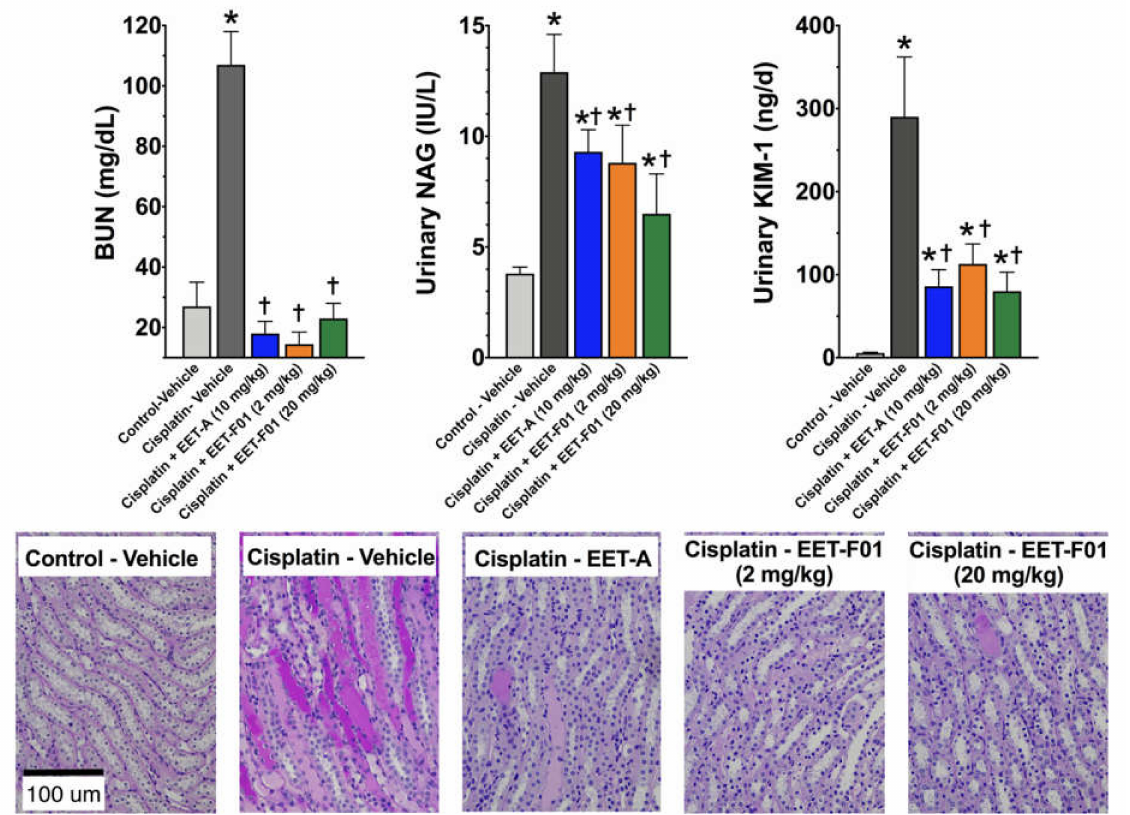
Figure 2. Kidney injury induced by cisplatin is reduced by EET-F01 and EET-A treatments. Left panel: blood urea nitrogen (BUN), Middle panel: urinary N-acetyl- β -(D)-glucosaminidase (NAG), Right panel: kidney injury molecule-1 (KIM-1) in cisplatin administered rats treated with vehicle, EET-F01, or EET-A. Bottom panel: Representative photomicrographs of Periodic acid-Schiff (PAS) Staining depicting vacuolation and desquamation of the renal epithelial cells along with severe intra-tubular proteinaceous cast tubular cast formation in the renal sections of different experimental groups. * p < 0.05 vs. control–vehicle group; † p < 0.05 vs. cisplatin–vehicle group. Data expressed as mean ± SEM, n =